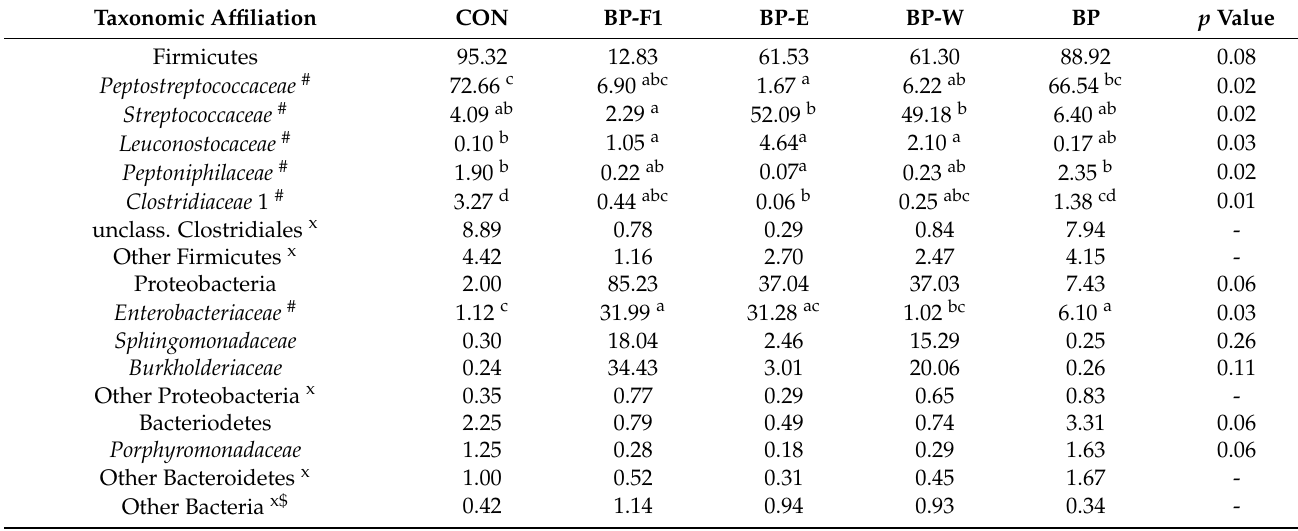
Table 4. Mean relative abundance (%) of main bacterial phyla and families identified in the intestine of hybrid striped bass. Taxonomic